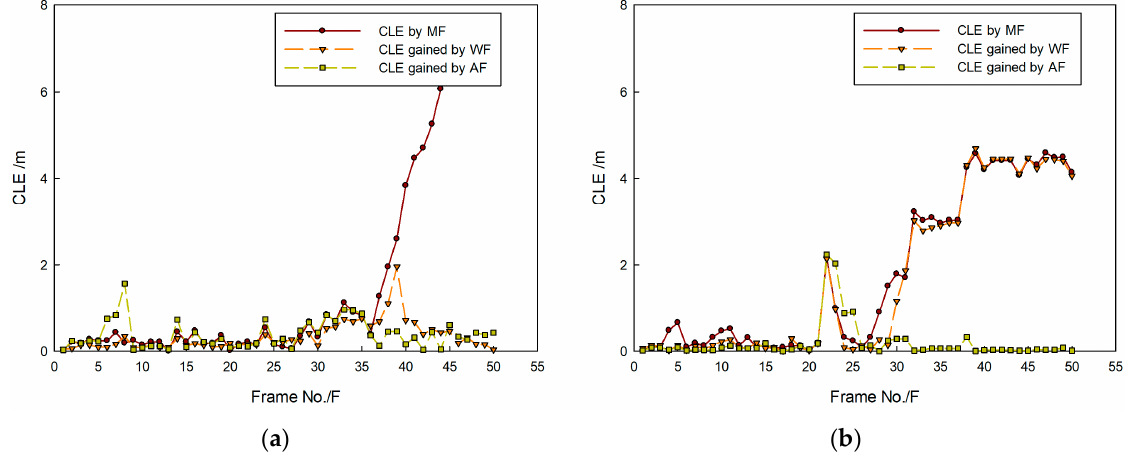
Figure 19. CLE gained by different fusion methods: results of ( a ) first target and ( b ) second target.